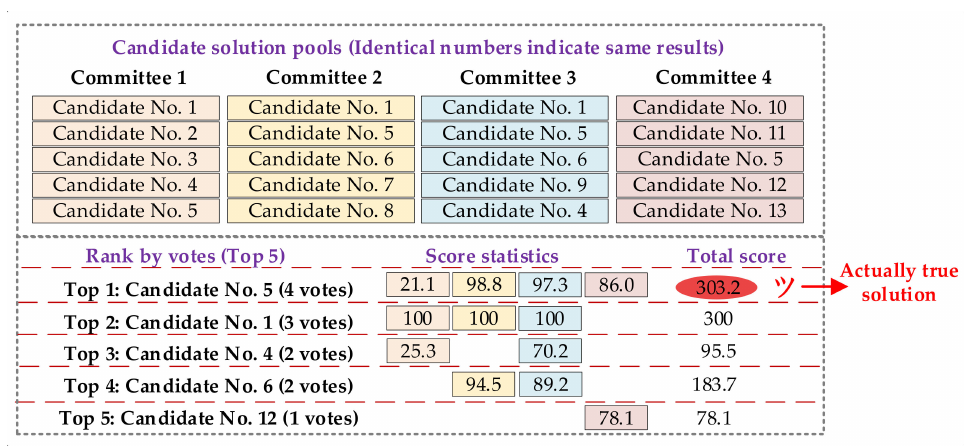
Figure 6. Detailed decision-making process for scenario 2.